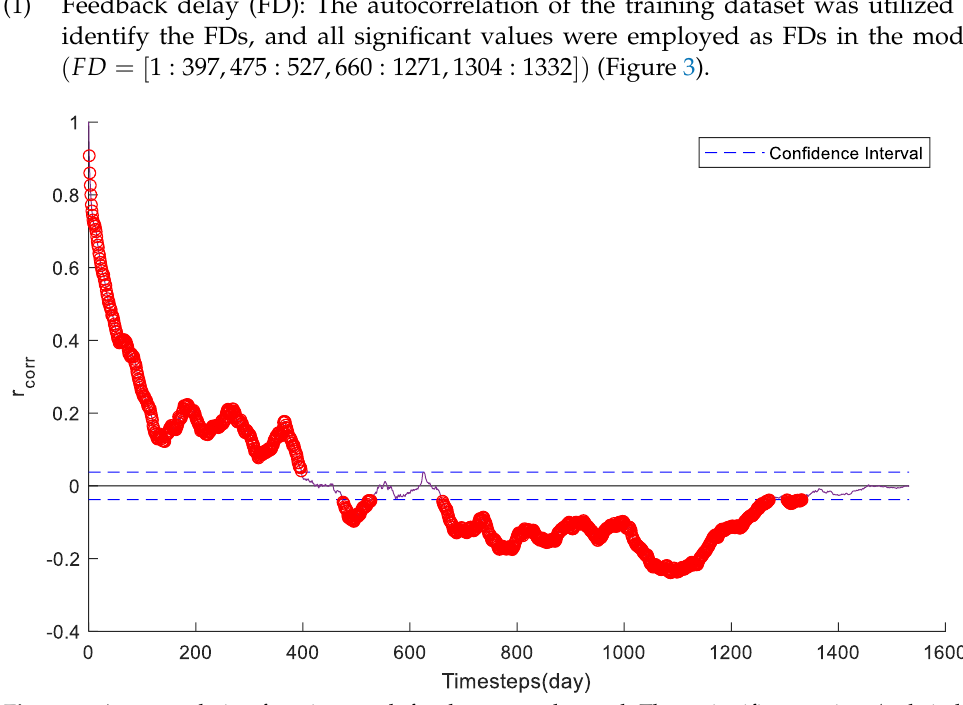
Figure 3. Autocorrelation function result for the power demand. These significant points (red circles) were used as the FDs in the model development